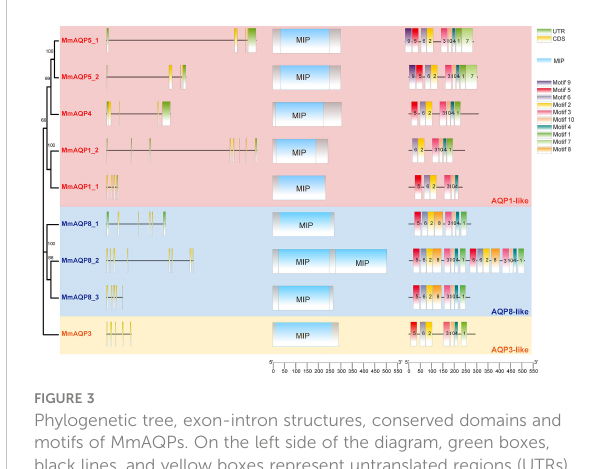
FIGURE 3 Phylogenetic tree, exon-intron structures, conserved domains and motifs of MmAQPs. On the left side of the diagram, green boxes, black lines, and yellow boxes represent untranslated regions (UTRs), introns, and exons, respectively. In the middle, blue boxes represent the MIP domains. On the right, 10 boxes of different colors represent different motifs. The AQP1-like, AQP8-like, and AQP3-like subfamilies are marked with pink, blue, and yellow, respectively.